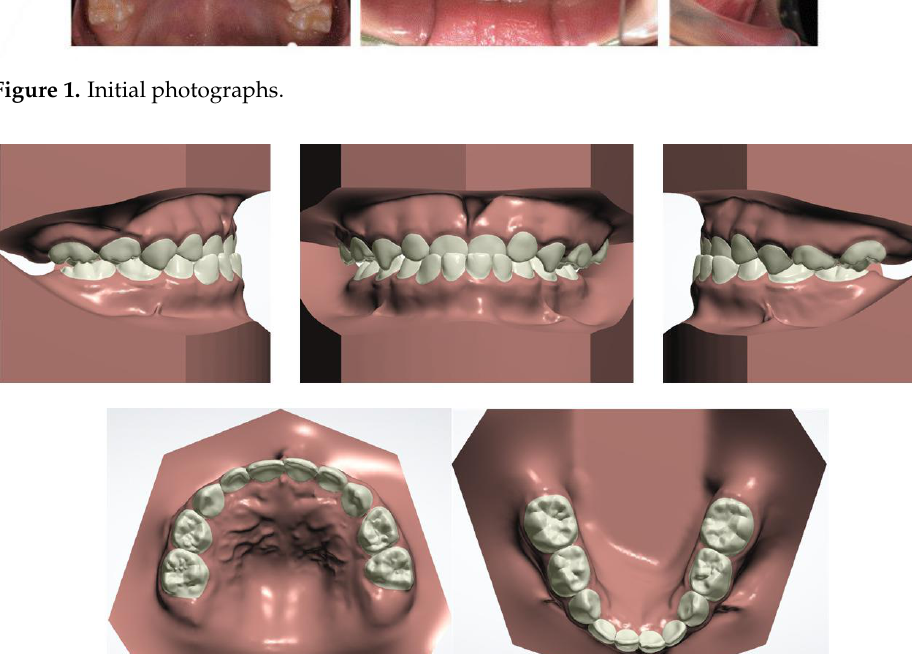
Figure 2. Initial digital study models.